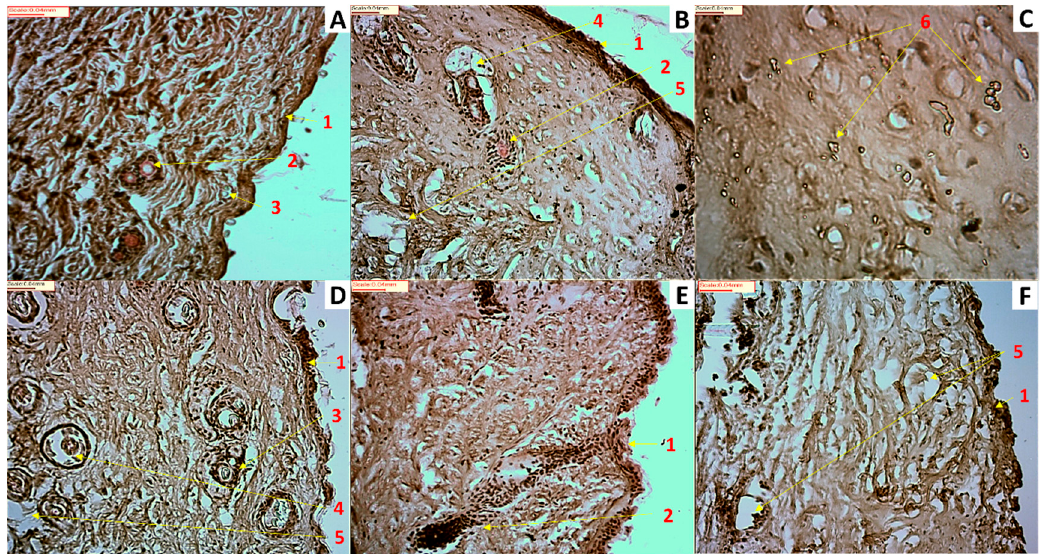
Figure 7. Photomicrographs of untreated and exposed to HQ formulations mouse skin. A ) Untreated skin (20× magnification); B ) Skin exposed to HQ1 formulation (20× magnification); C ) Skin exposed to HQ1 formulation (40× magnification); D ) Skin exposed to HQ2 formulation (20× magnification); E ) Skin exposed to HQ3 formulation (20× magnification); F ) Skin exposed to HQ4 formulation (20×